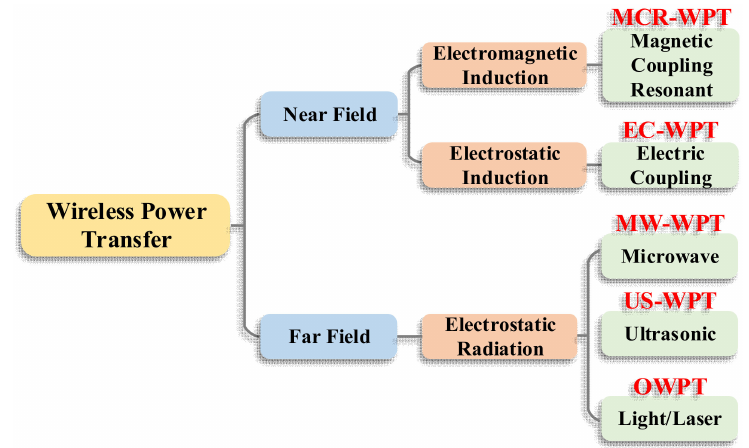
Figure 1. Classification of wireless power transfer